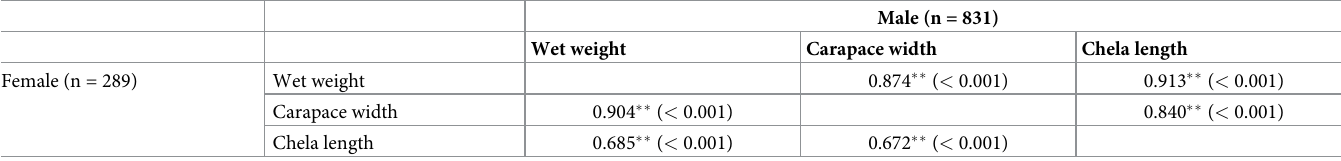
Table 1. Correlation results of body weight (g), carapace width (cm), and chela length (cm) of male and female Xenograpsus testudinatus according to pearson’s cor- relation analysis.